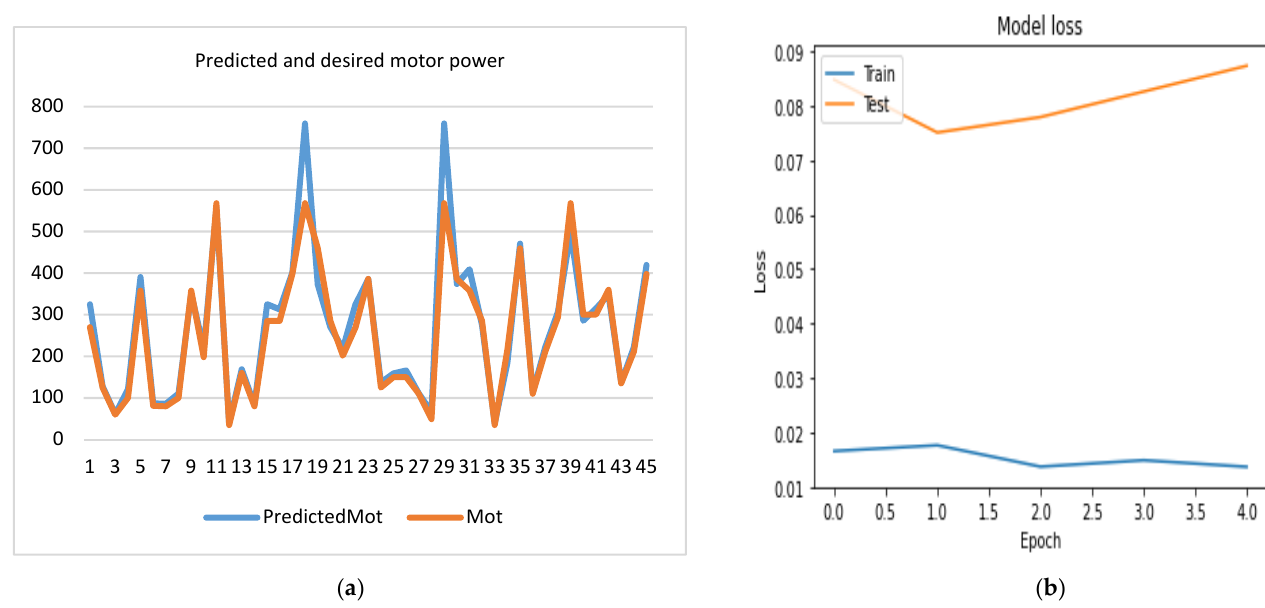
Figure 13. Predicted electrical motor power analysis. ( a ) Behaviour of the predicted electrical motor power; ( b ) Model loss with increase in epoch.